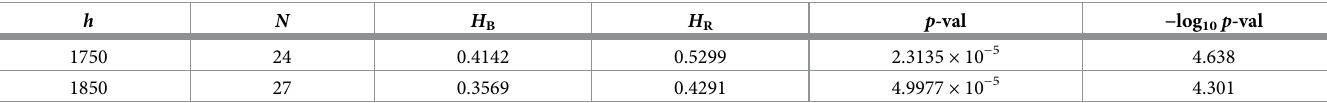
Table 4. Estimated Hurst exponent values for mung beans (B) signal and reference signal (R). h N